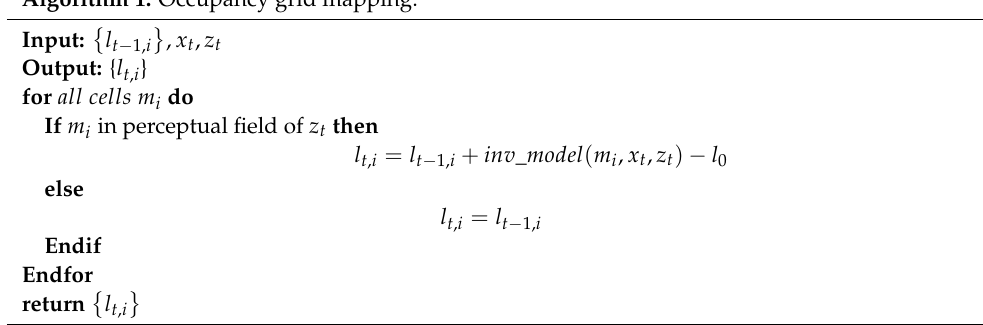
Algorithm 1: Occupancy grid mapping.